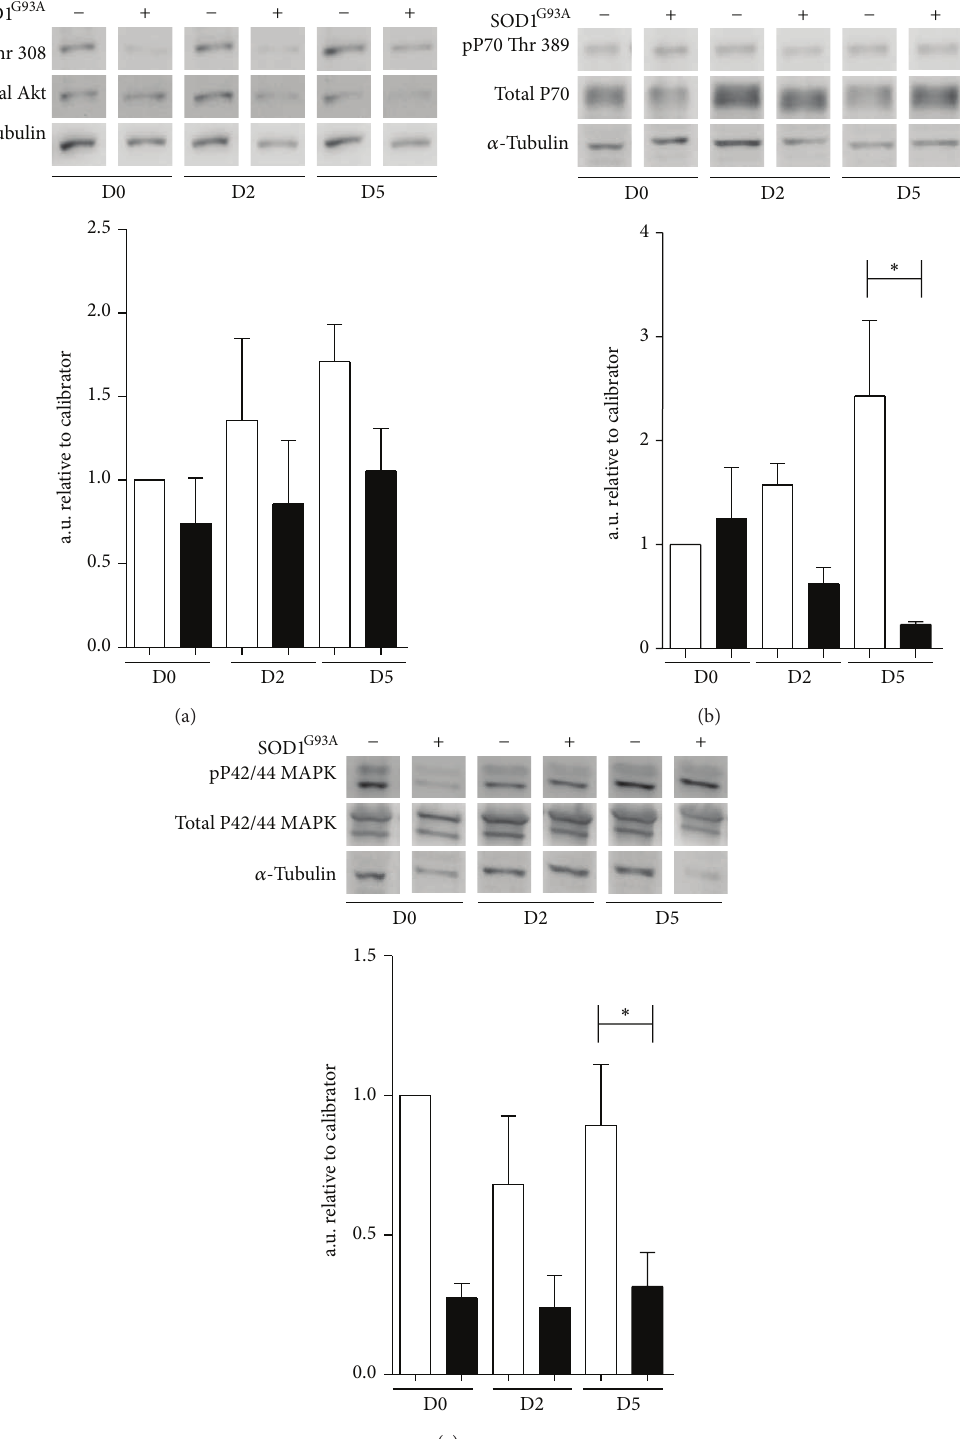
Figure 4: Muscle specific expression of human mutant SOD1 gene alters signaling pathways in muscle differentiation. (a) Representative western blot analysis for phospho-Akt (Thr 308) and total Akt expression (upper panel) and densitometric analysis (lower panel) of the ratio between phosphorylated Akt and the total form (lower panel) in C2C12 (white bars) and C2C12 MLC/SOD 1 G 93 A (black bars). (b) Representative western blot analysis for phospho-P70 (Thr 389) and total P70 expression (upper panel) and densitometric analysis (lower panel) of the ratio between phospho-P70 and total P70 (lower panel) in C2C12 (white bars) and C2C12 MLC/SOD 1 G 93 A (black bars). (c) Representative western blot analysis of phospho-p42/44 MAPK and p42/44 MAPK expression (upper panel) and densitometric analysis (lower panel) of the ratio between phospho-p42-44 MAPK and total p42/44 MAPK in C2C12 (white bars) and C2C12 MLC/SOD 1 G 93 A (black bars). D0, D2, and D5 referred to days of culture in differentiation condition. Data are represented as mean ± SEM ( ∗ 𝑃 < 0.05